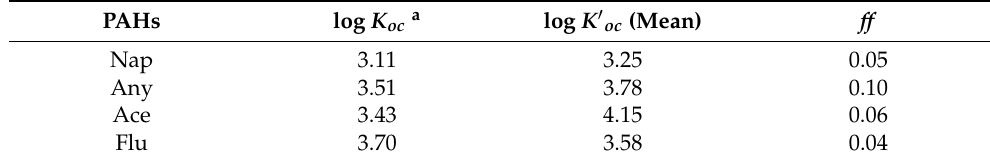
Table 2. Comparison of log K oc and log K (cid:48) oc for polycyclic aromatic hydrocarbons (PAHs) at the water-sediment interface and the fugacity fraction ( ff ) in the study